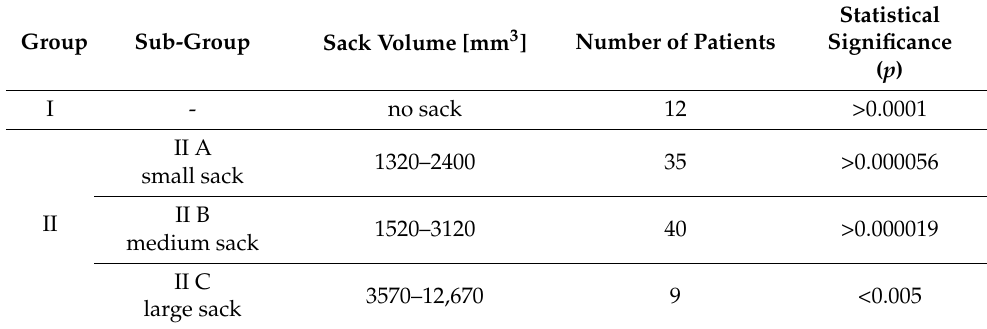
Table 1. The incidence of hernia sack in the study groups and sub-groups.